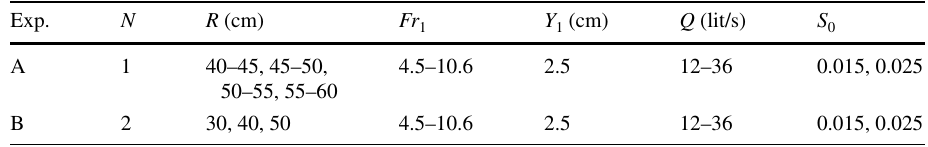
Table 1 Summary of experimental parameters